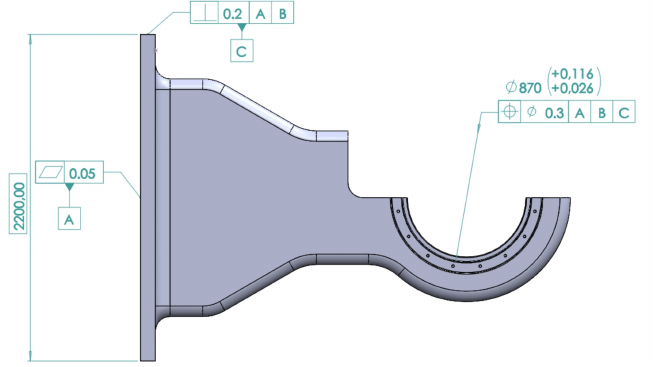
Figure A1. Tolerances of the main support that can influence the tolerance chain